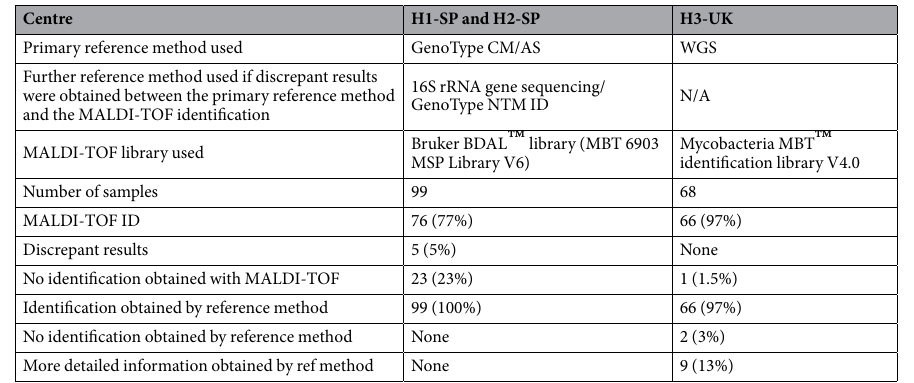
Table 1. Results of identifications and reference methods used.